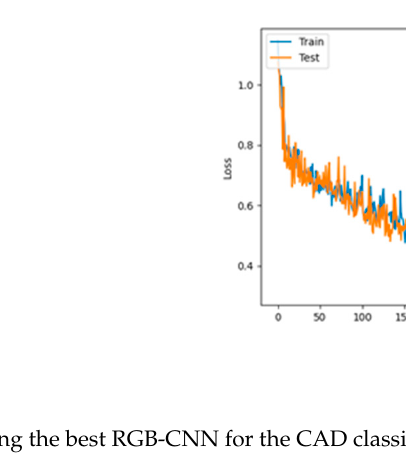
( b ) Figure 8. Plots demonstrating the VGG-16 for comparing reasons, for the CAD classification prob- lem: ( a ) accuracy; ( b ) loss.